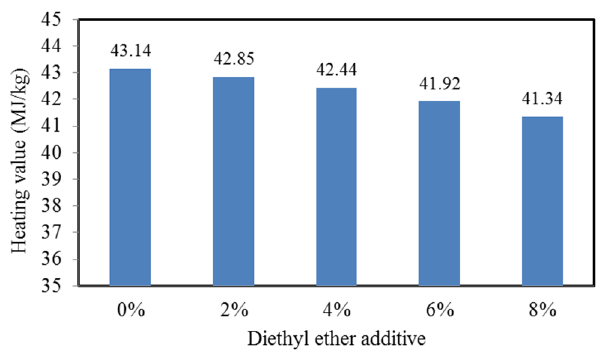
Figure 4. Effect of increasing diethyl ether percentage on blended B30 fuel heating value.